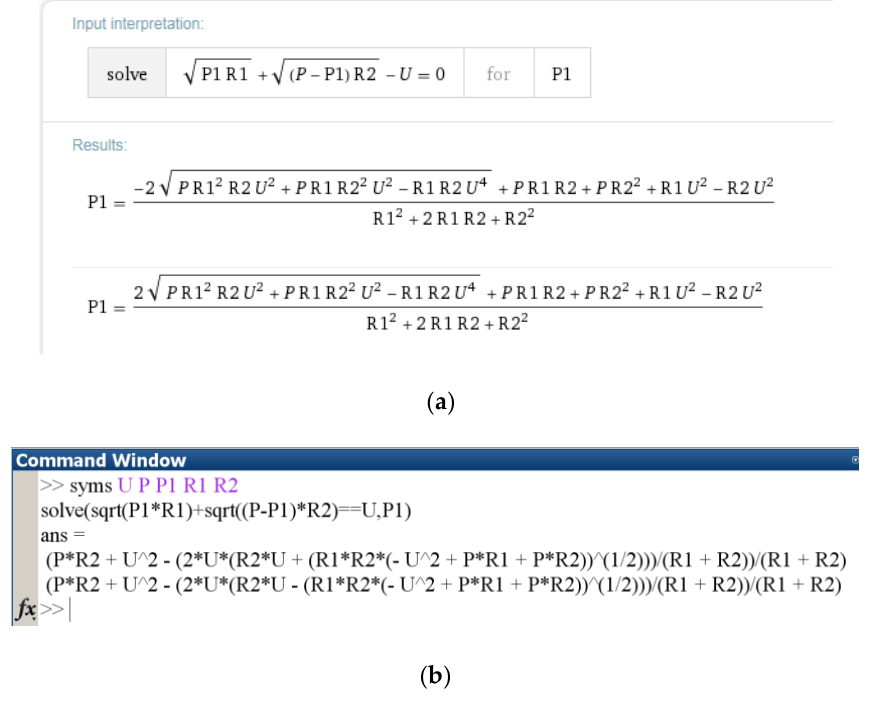
Figure 6. Listings of the programs for the symbolic solution of Equation (2) with the packages: ( a ) Wolfram Mathematica; ( b ) Matlab.